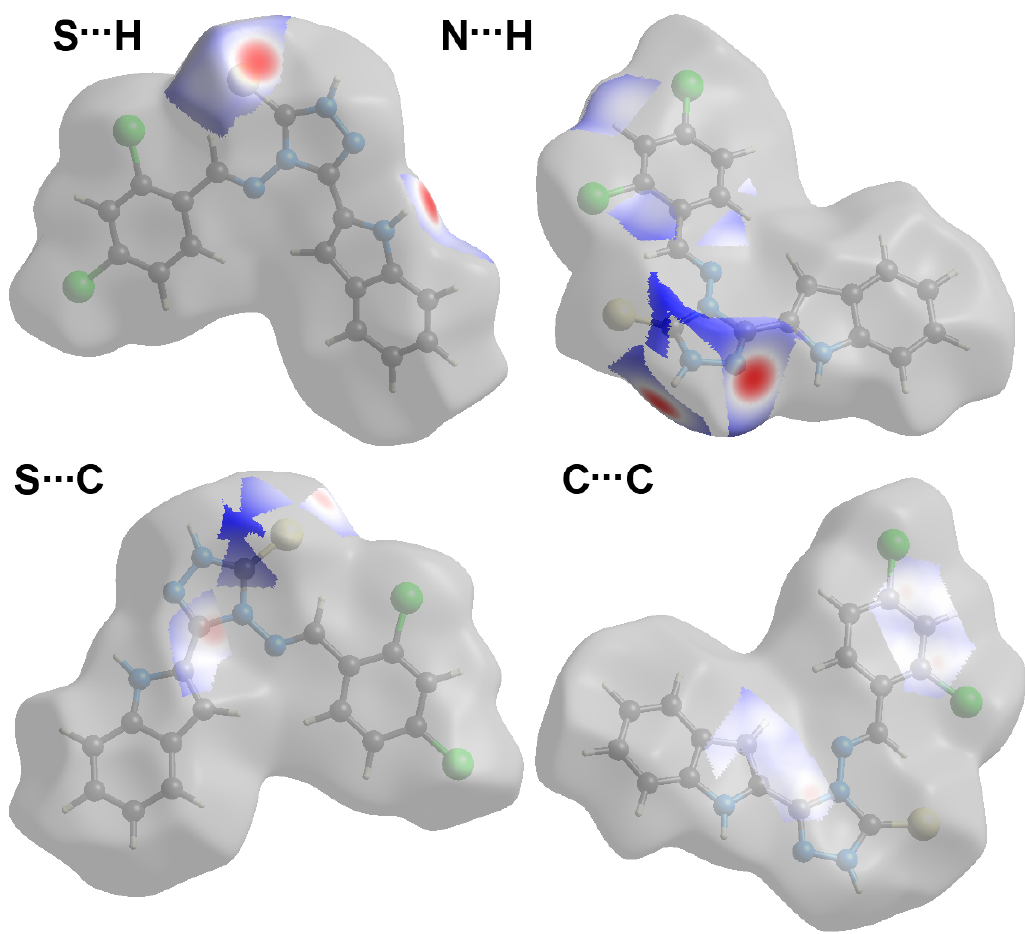
Figure 9. Decomposed d norm maps of the most important contacts in 4 .